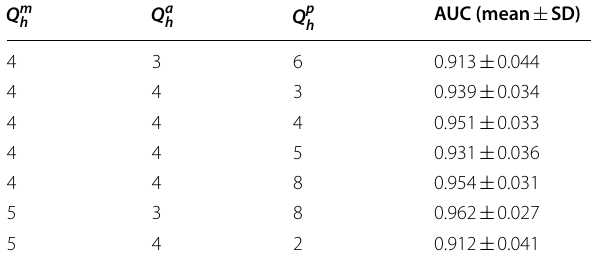
Table 7 AUC scores of THV (or T of Hessian magnitude, Hessian azimuth and Hessian polar angle where the t -th root is set to be